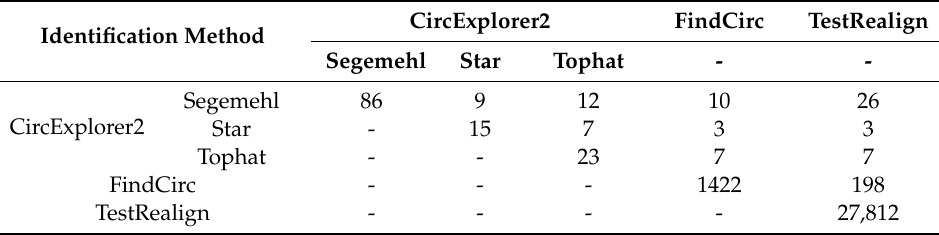
Table 1. Number of circRNAs identified in AGO-IP libraries by 5 different methods.